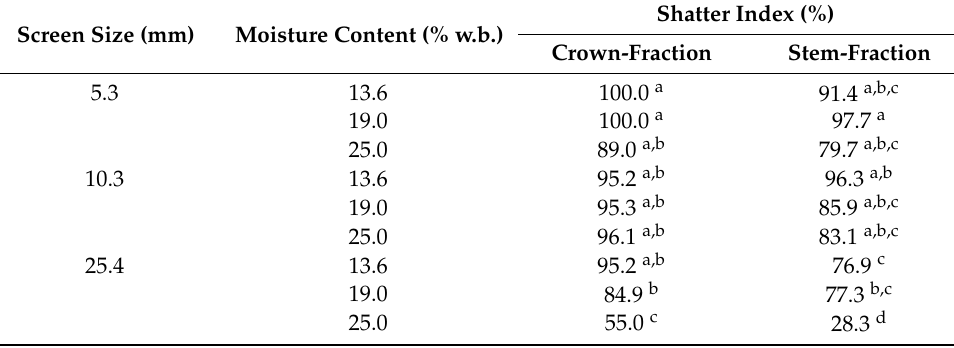
Table 8. Mean values of shatter index of briquettes from poplar tree